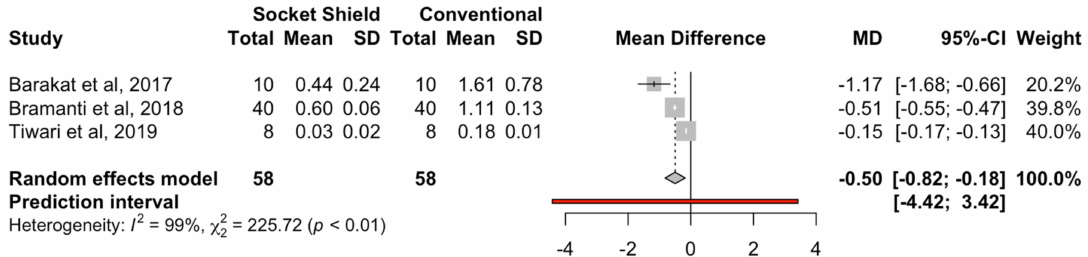
Figure 5. Forest plot of the mean difference in marginal bone loss (mm) between immediate dental implant placement using the socket-shield technique and conventional placement